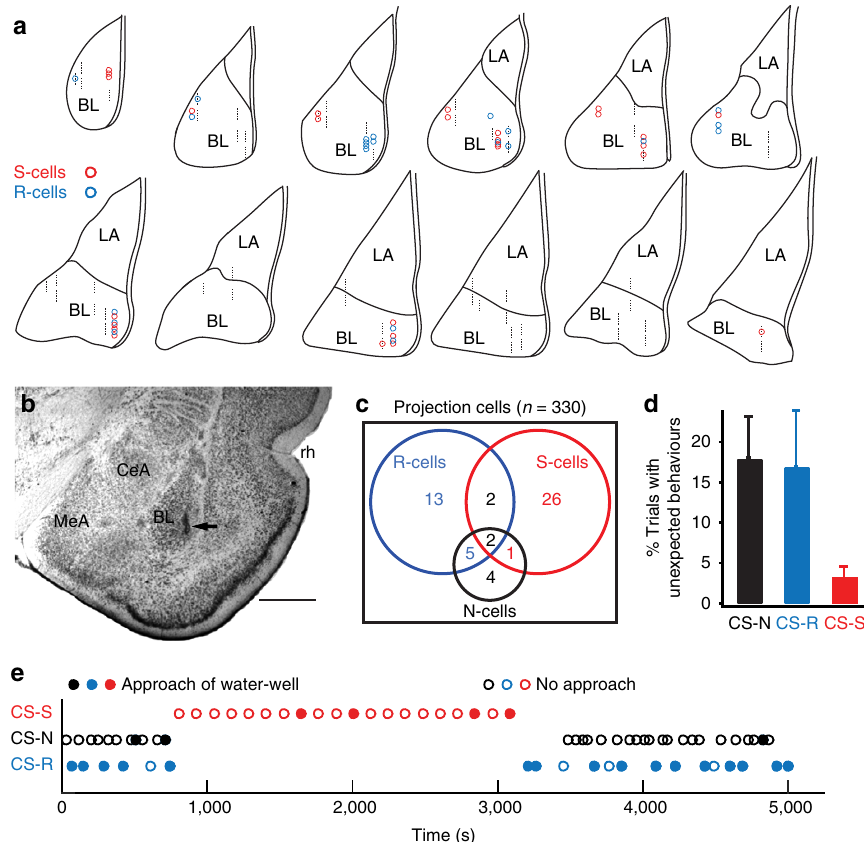
Figure 1 | Experimental paradigm. ( a ) Schemes showing location of cells excited by the CSs (coloured circles). Dashed lines: recording sites where no cells excited by the CSs were detected. Cells excited only by the CS-N are not shown. Cells excited by the CS-R and other CS types are indicated as R-cells. ( b ) Coronal section with electrolytic lesion (arrow) marking recording site. Scale bar, 1mm. ( c ) Venn diagram summarizing the CS responsiveness of projection cells. ( d ) Proportion of trials with unexpected behaviours emitted during the three CSs (average ± s.e.m.; five rats). ( e ) Timing ( x axis) of CS presentations ( y axis) in one rat. Filled and empty circles: trials where CS triggered approach of water-port or not. CR-R, CS predicting reward; CS-N, neutral CS; CS-S, CS predicting footshock; N-Cells, R-Cells and S-Cells are cells with significantly increased firing rates during the CS-N, CS-R and CS-S,